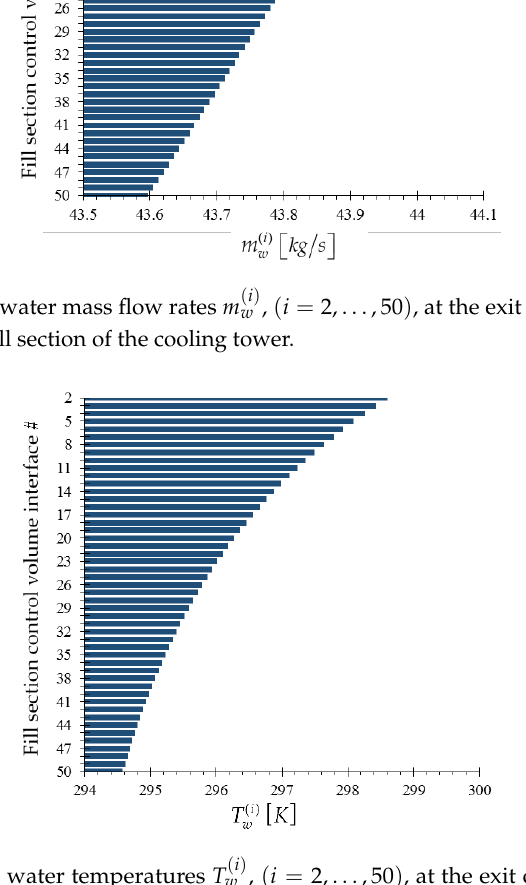
Figure 5. Bar plot of the water temperatures ( ) i T along the height of the fill section of the cooling tower.